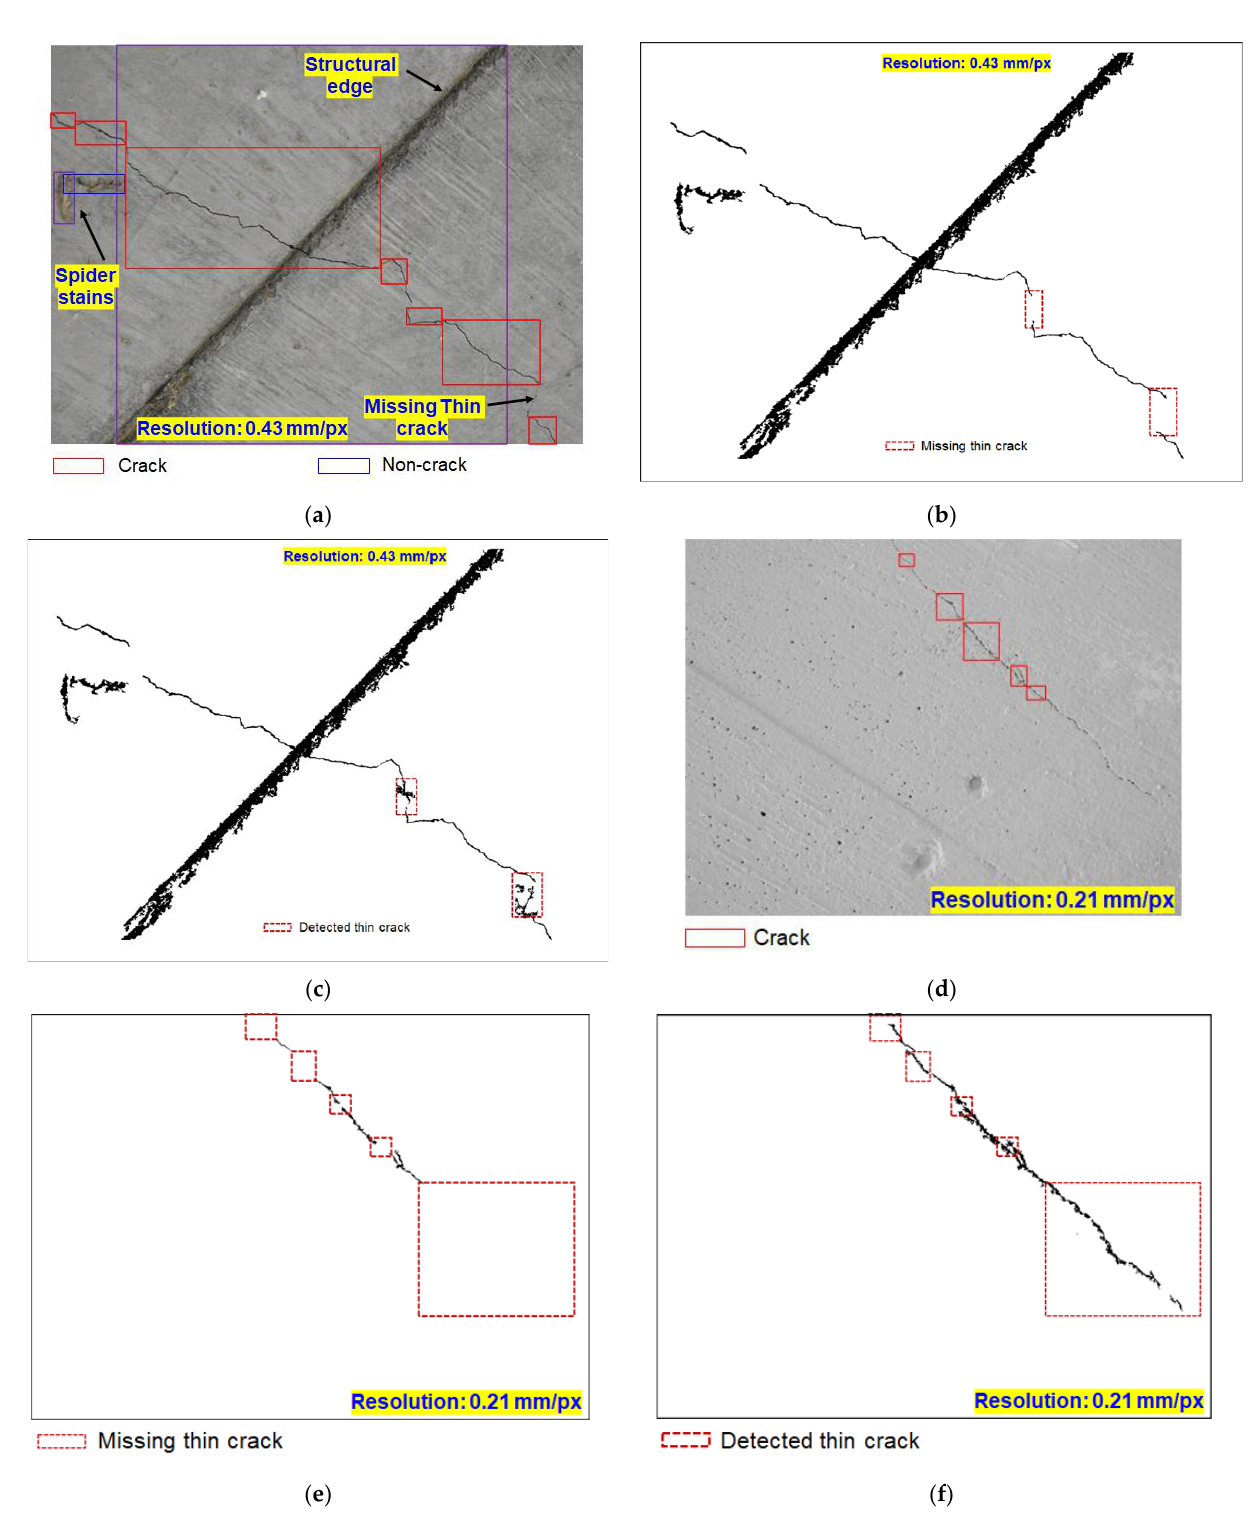
Figure 10. ( a , d ) Classification of crack in presence of non-crack features including structural edge, spider stains, peeling of concrete surface coating, stains and discoloration, and markings. ( b , e ) Representative pixelated results for crack and non-crack features shown in ( a , d ) , respectively. ( c , f ) Missing thin shallow cracks of single-pixel width (see ( b , e )) detected using DL-assisted image processing.